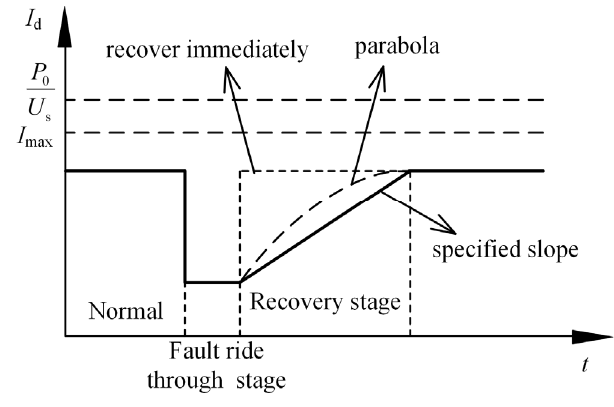
Figure 4. Transient active current response of PV unit with LVRT function.